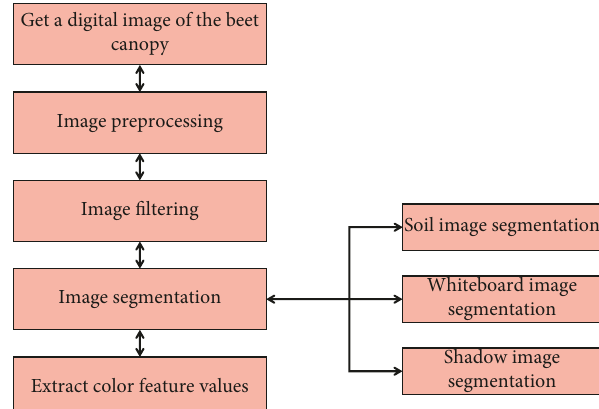
Figure 2: Flow chart of image color feature information extraction.